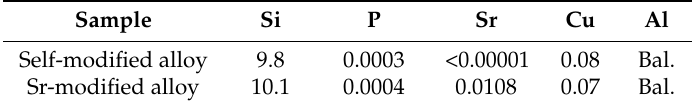
Table 1. Chemical composition of prepared cast alloys (wt.%).